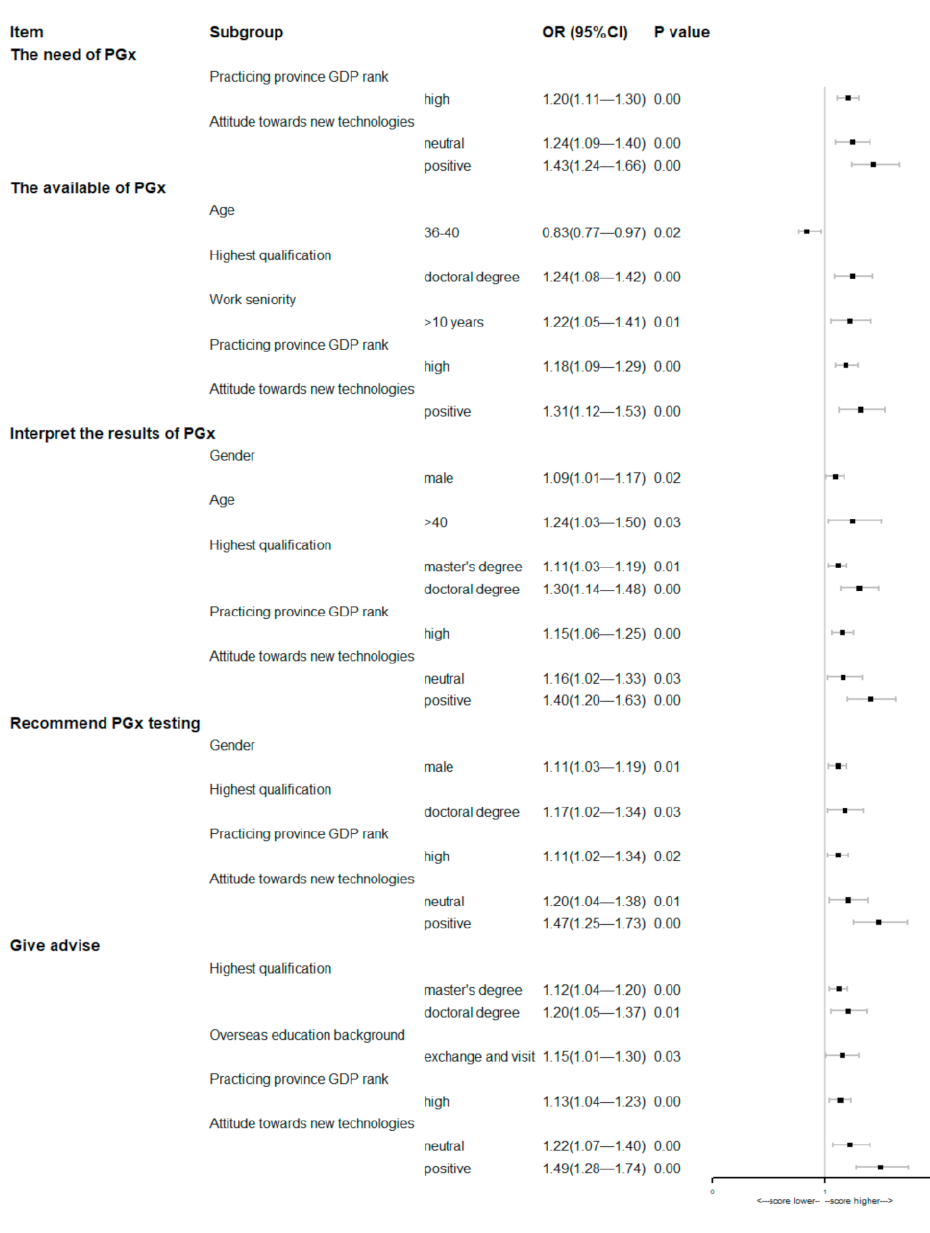
Figure 4. Forest plots of multivariate analyses of respondents’ baseline characteristics associated with the self-assessment of the competencies related to PGx testing (the first option listed in Table 1 was used as the control group, except for